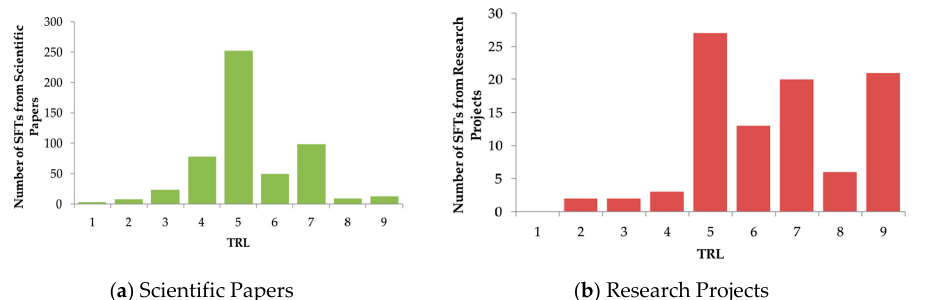
Figure 2. Technological readiness level (TRL) of the identified smart farming technologies (SFTs) in ( a ) scientific papers and ( b ) research projects. TRL ranges from TRL1 (basic principles observed) to TRL9 (actual system in operational environment) [99] and was defined using the AFRL TRL Calculator (version 2.2.) [100]. Commercial SFTs were excluded by this process (they all had